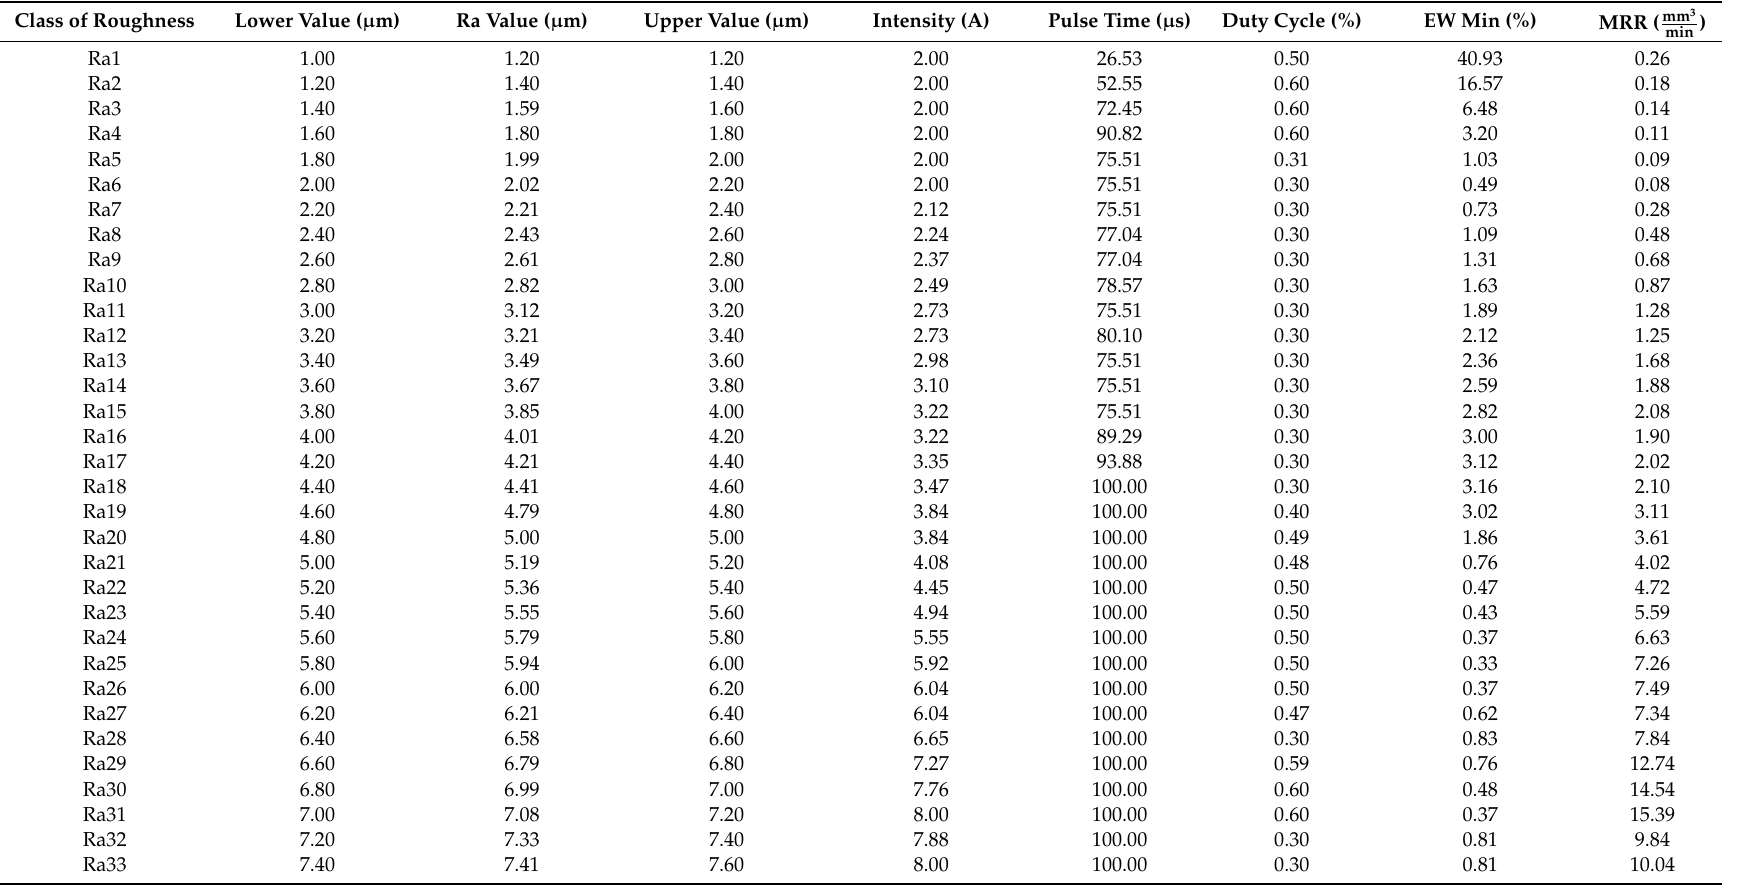
Table 6. Strategy of minimum electrode wear. Technological table obtained from the FIS, for the case of minimum electrode wear strategy (positive polarity). Class of